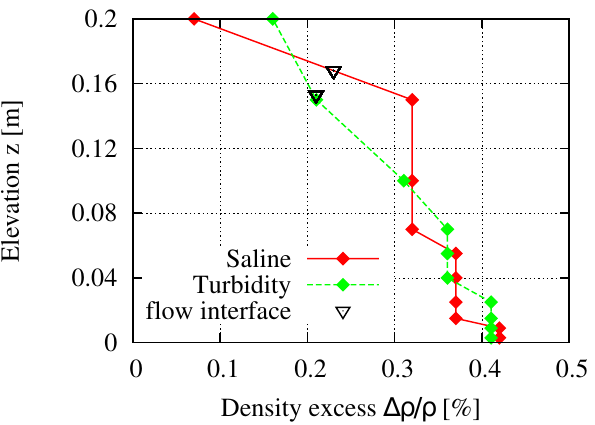
Figure 10. Density profiles: comparison between a saline current (experiment S14) and a turbidity current (experiment S25), mea- sured in cross section C5. The black triangles indicate the flow in- terface level of each current.